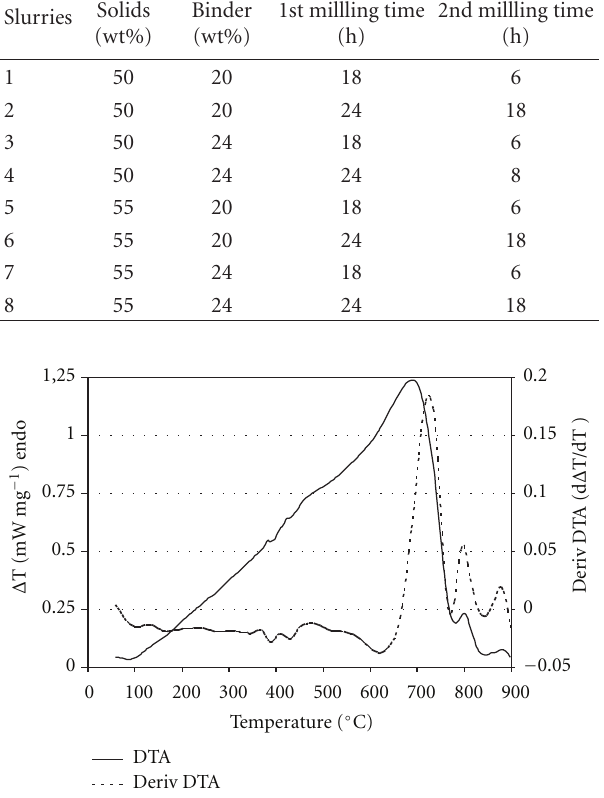
Figure 3: Di ff erential thermal analysis (DTA) of LZSA.